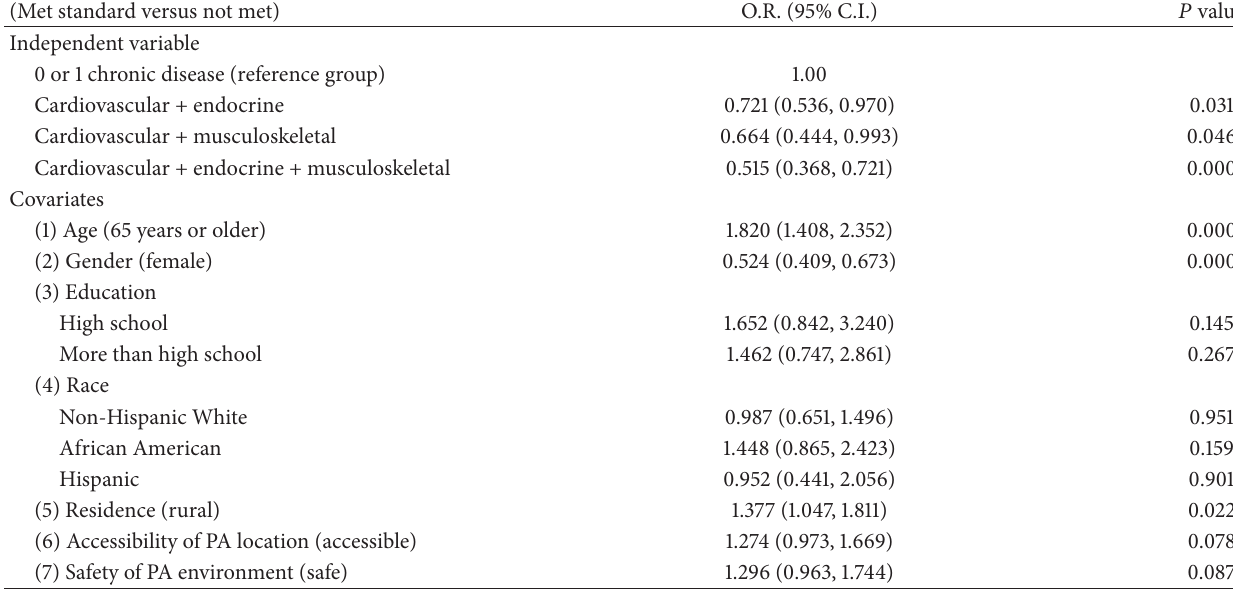
Table 3: Logistic regression to identify relationships between PA level and disease combinations, adjusted by covariates. (Met standard versus not met) O.R. (95%